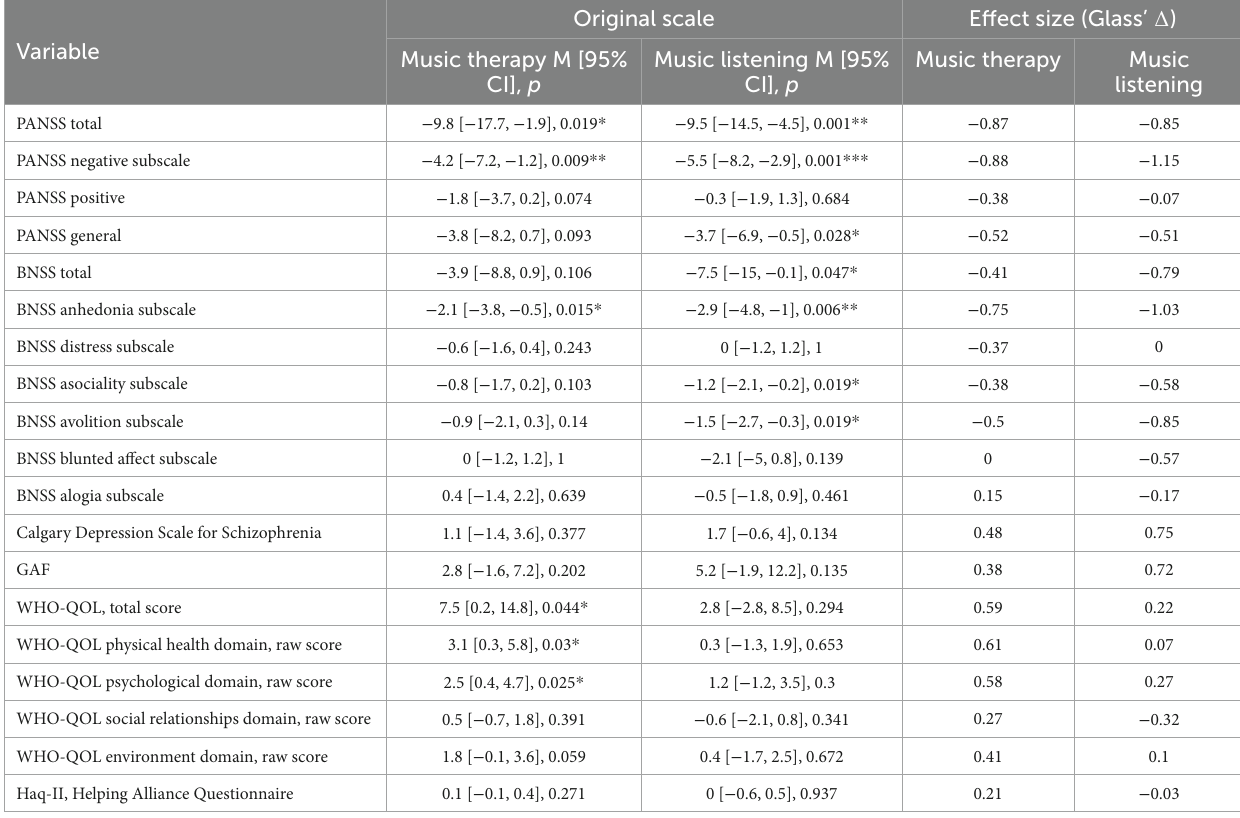
TABLE 3 Within-group analysis of changes over time in each